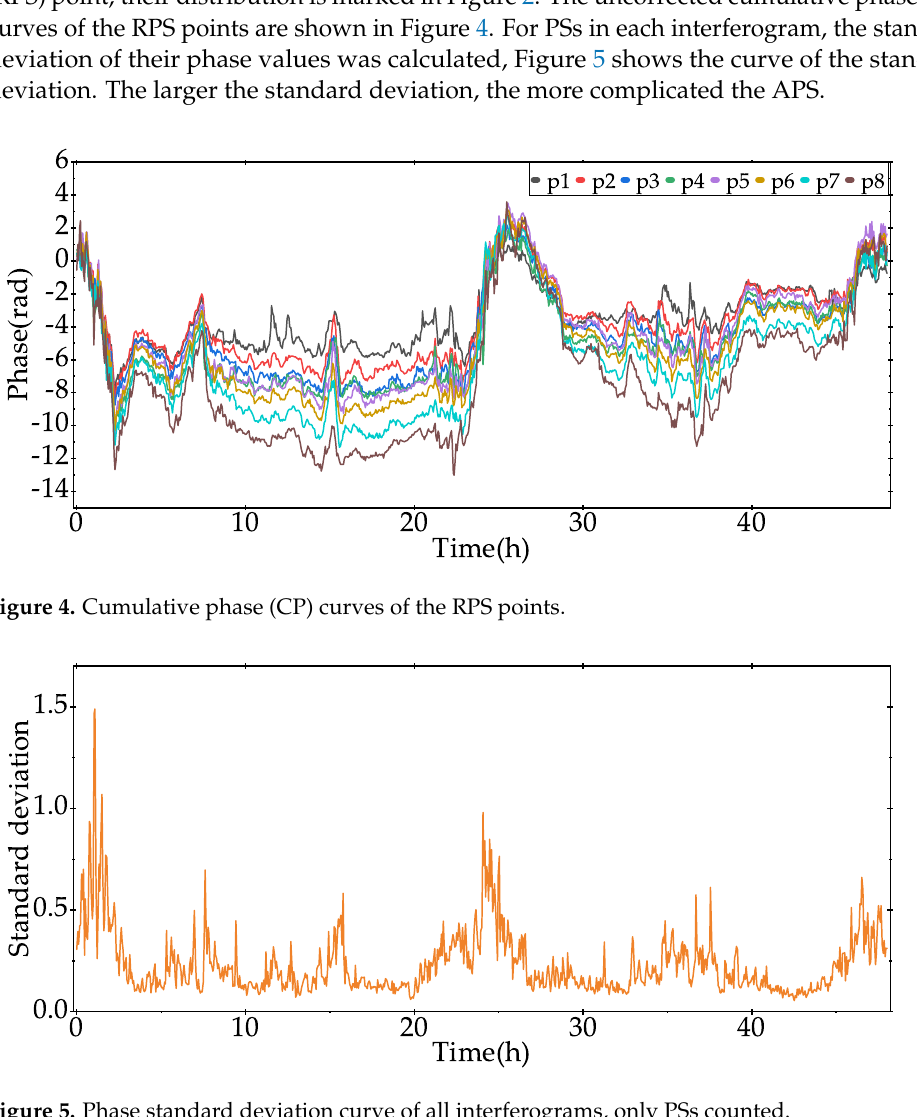
Figure 5. Phase standard deviation curve of all interferograms, only PSs